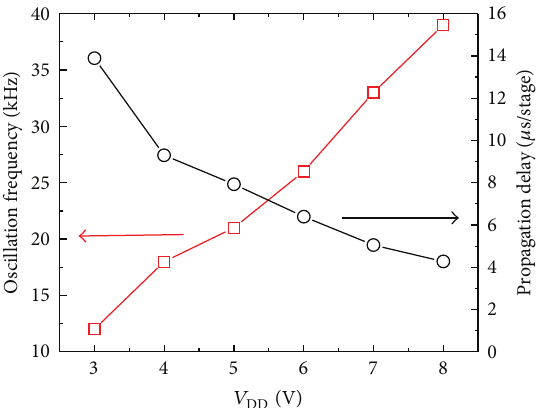
Figure 8: Variation of frequency of oscillation and propagation delay with supply voltage in a three-stage ring oscillator.